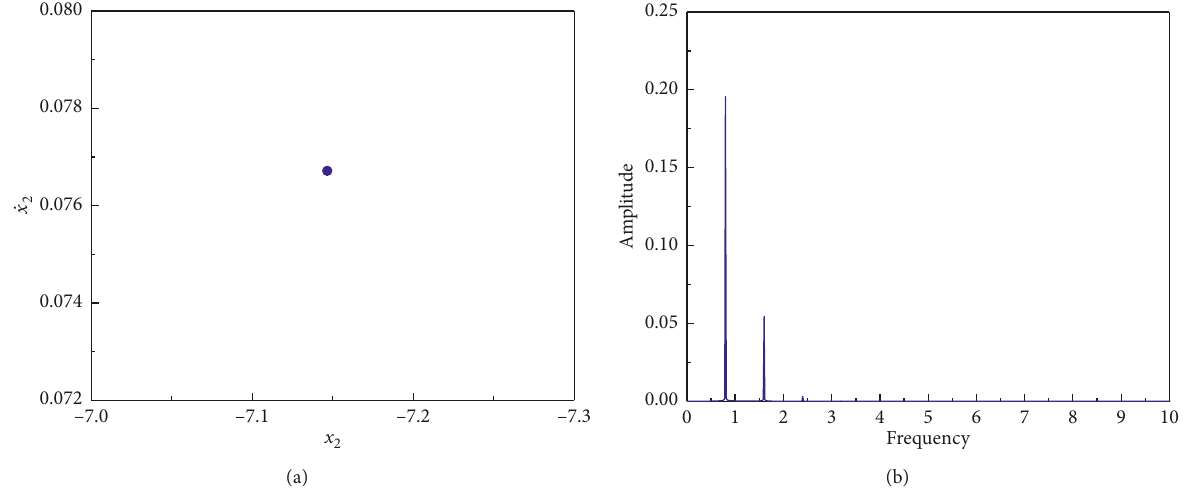
Figure 13: Period-1 motion of the baseplate for Ω � 0 . 8.